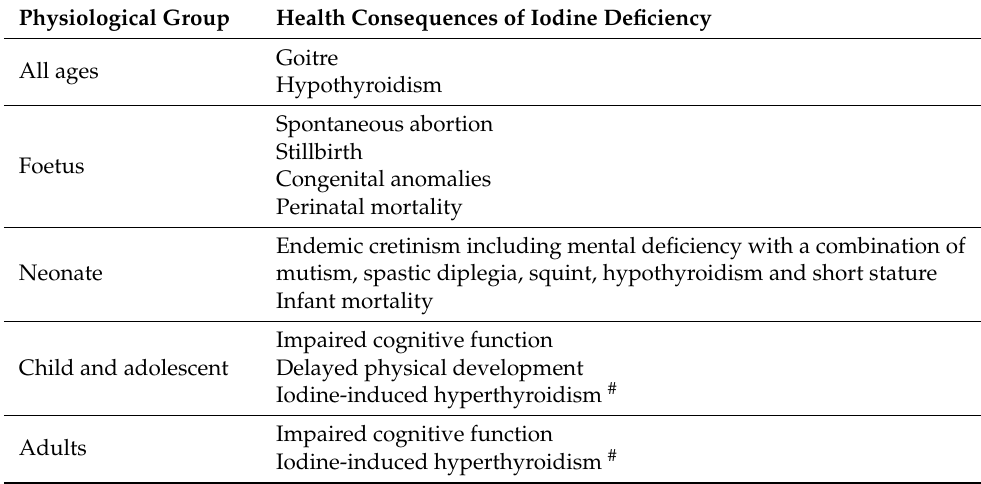
Table 1. Iodine deficiency disorders according to physiological group adapted from [3]. Physiological